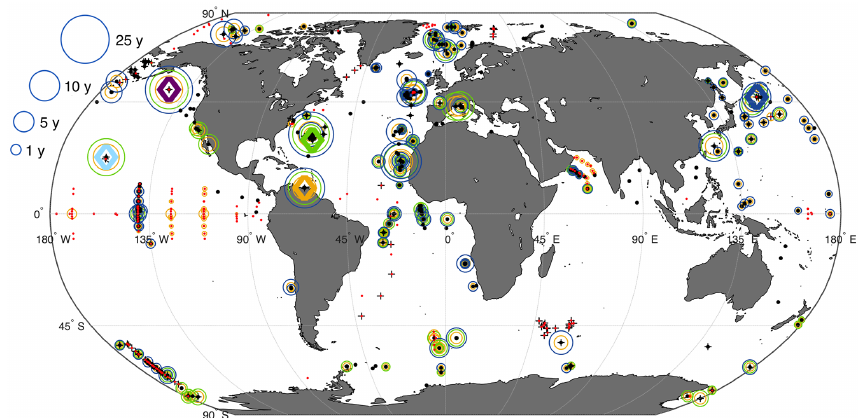
Figure 1. Geographical distribution of POC flux observations at 673 independent sites. The size of the circle indicates the length of the data record at a given site (see legend). The color of the circles indicate the depth of observation, where orange is ≤ 100m, green is > 100 and ≤ 1000m, and dark blue is > 1000m. The location of sediment trap is indicated in black and the location of 234 Th data is in red. Plus symbols ( + ) indicate which observations are during the satellite era (i.e., September 1997–present). The diamonds highlight the locations of time series sites; BATS/OFP (green, 14%), CARIACO (orange, 10%), K2 (dark blue, 2%), OSP (purple, 7%), and HOT (light blue, 3%) account for 36% of the data